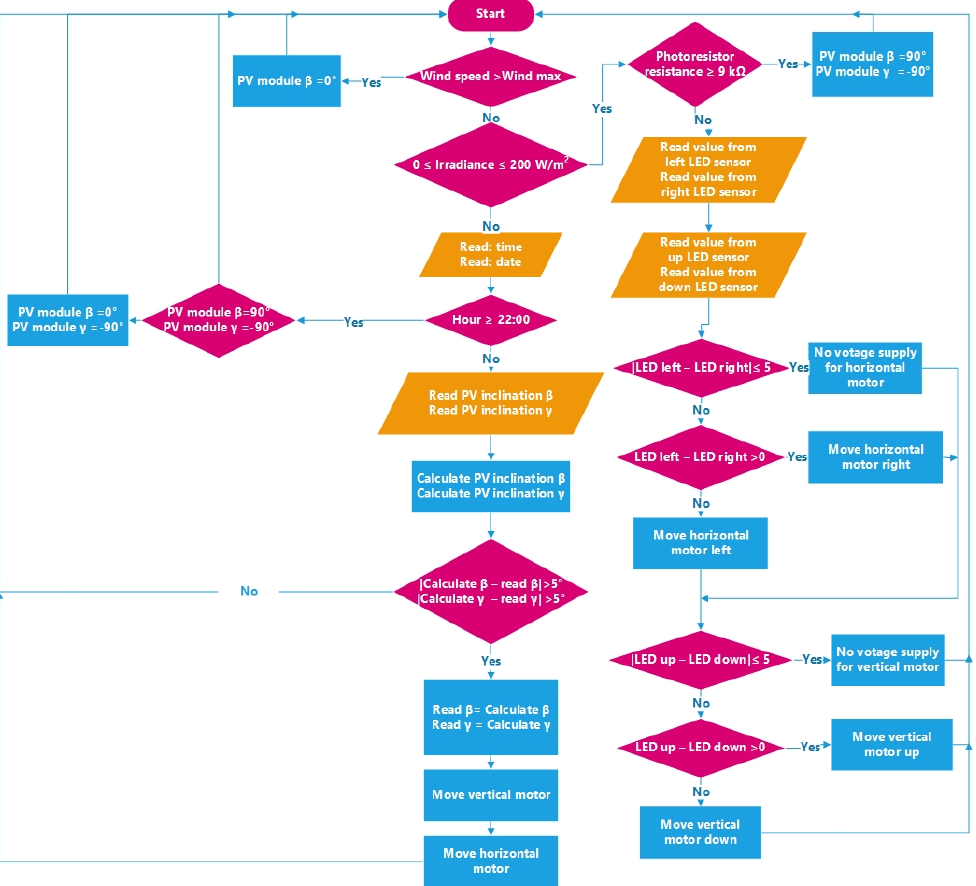
Figure 6. Implemented hybrid algorithm in two-axis tracking control unit. A schematic diagram of the tracking system is presented in Figure 7.